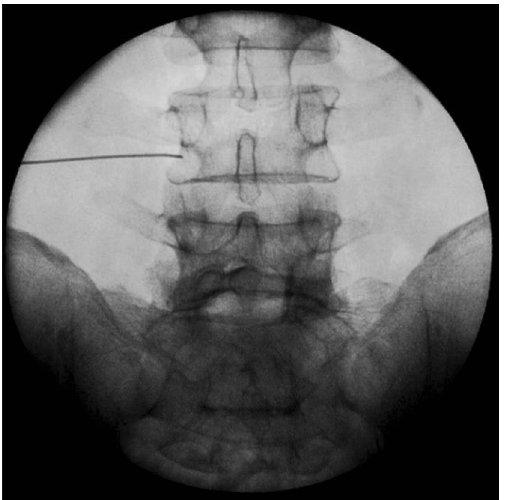
Figure 1. Fluoroscope verification of needle placement at L4/L5 in anterior–posterior